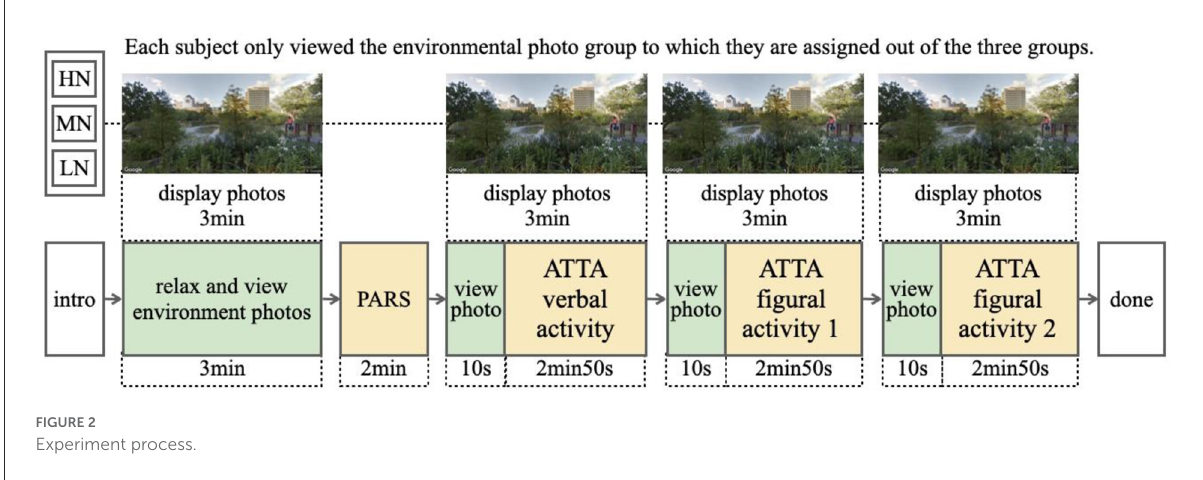
FIGURE2 Experiment process.